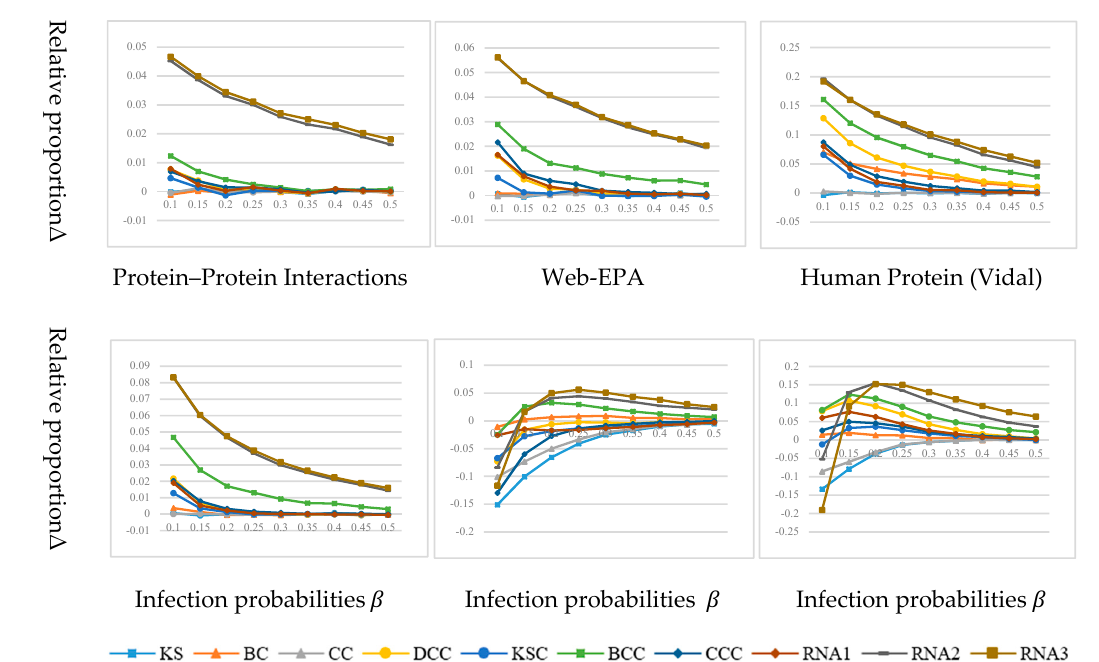
Figure 7. In full-contact SIR model, the relationship between Δ and β with 5% nodes in key node set.